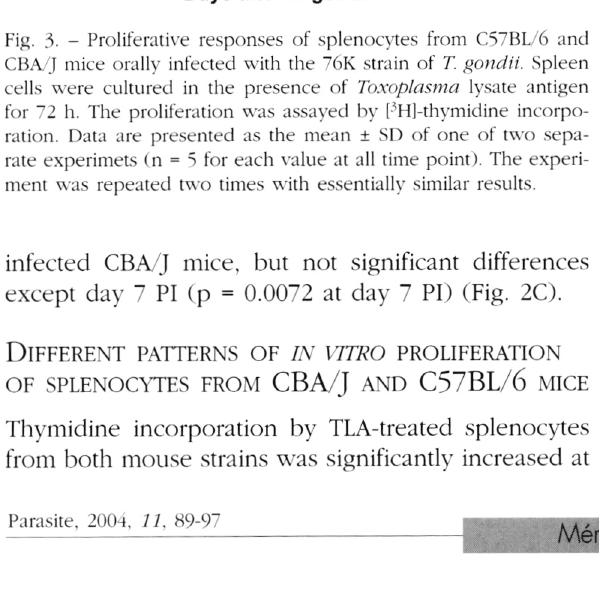
infected CBA/J mice, but not significant differences except day 7 PI (p = 0.0072 at day 7 PI) (Fig.